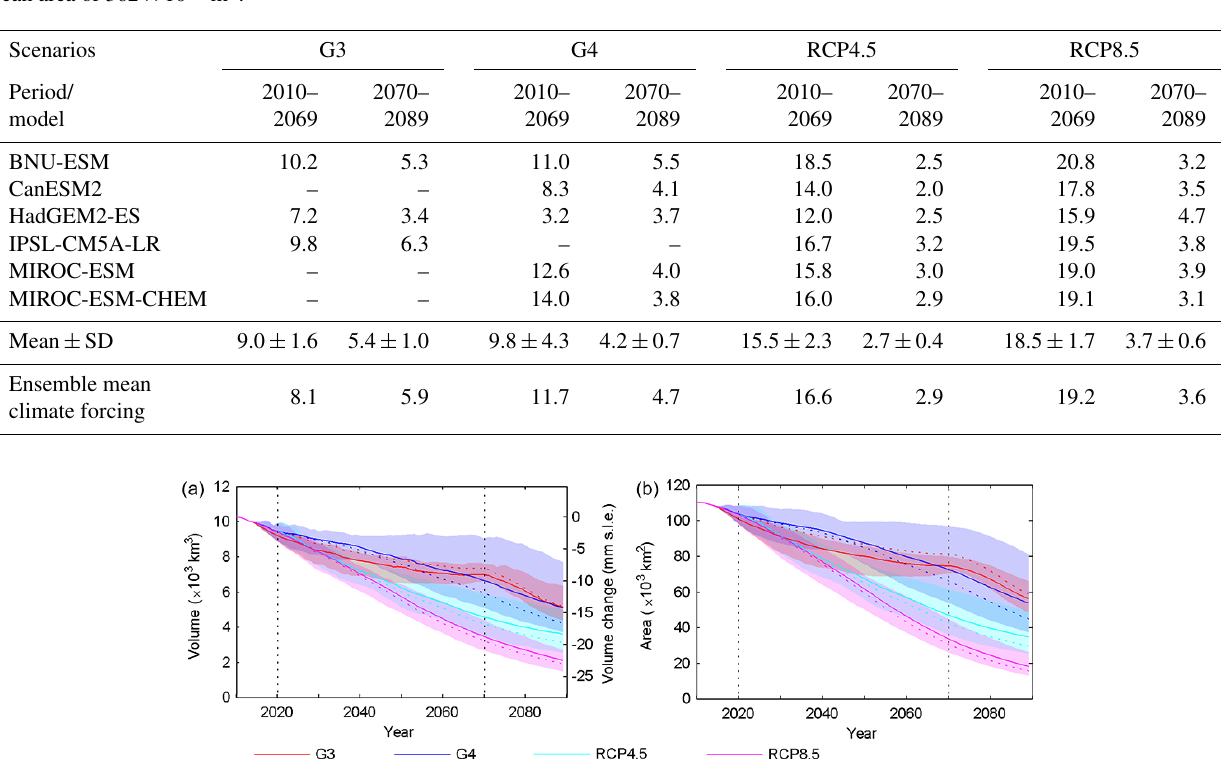
Figure 4. Total glacier volume in HMA (a) and the equivalent sea-level rise assuming an ice density of 900kgm − 3 and ocean area of 362 × 10 12 m 2 and area (b) from 2010 to 2089. The solid curves and shadings are means of individual climate-model-forced simulations and the across-model spread, for colour-coded scenarios. The dashed curves are results using multi-model ensemble mean temperature and precipitation forcing under each